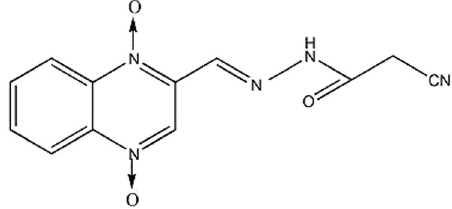
Figure 1. Chemical structure of cyadox (CAS No.:65884-46-0, MW = 271).